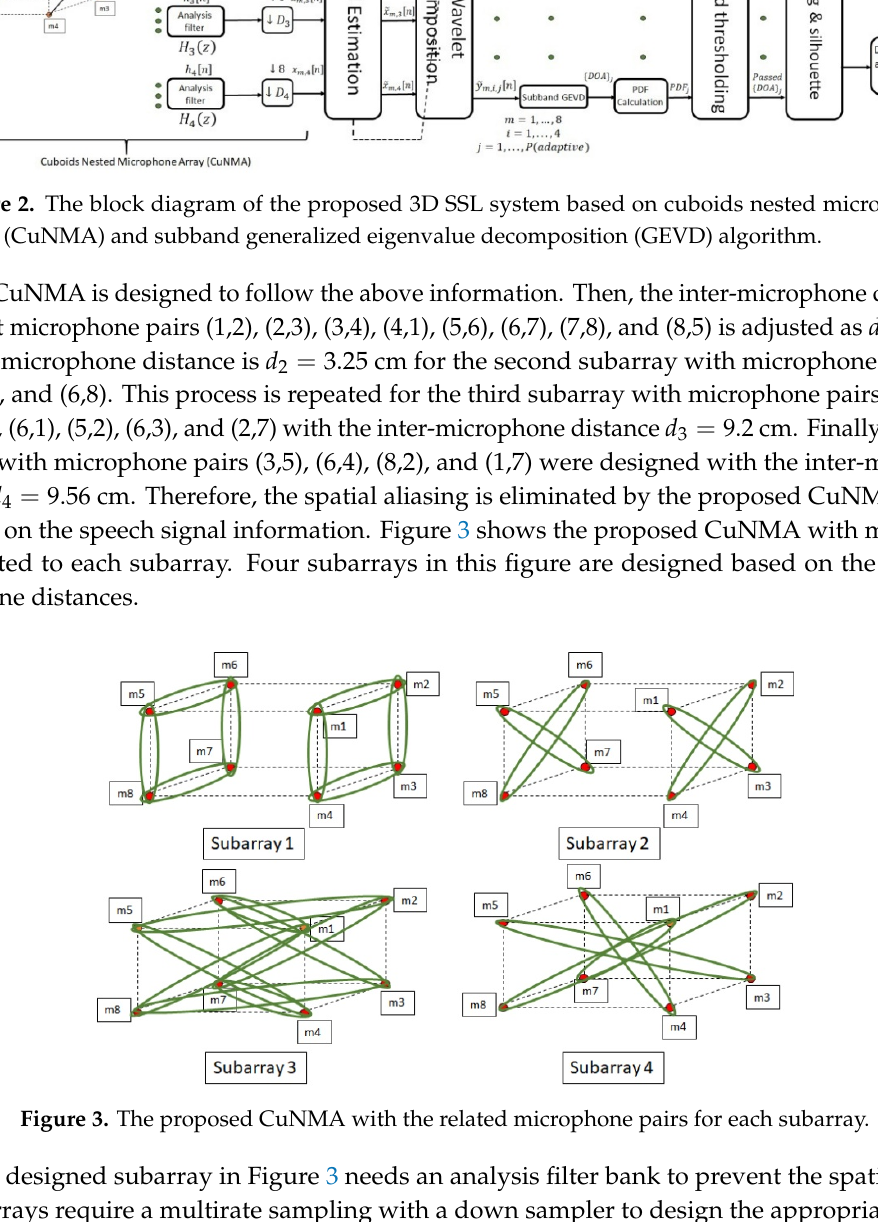
6 of 28 Figure 1. The near-field model for sound signal propagation in sound source localization (SSL) algorithms. 3.2. The Proposed Cuboids Nested Microphone Array for SSL The spatial aliasing due to the inter-microphone distances in microphone arrays destroys the spectral information of speech signal and decreases the accuracy of the localization algorithms. The nested arrays are usually used in speech enhancement applications owing to their elimination of spatial aliasing. The linear microphone array was proposed for a speech enhancement algorithm in